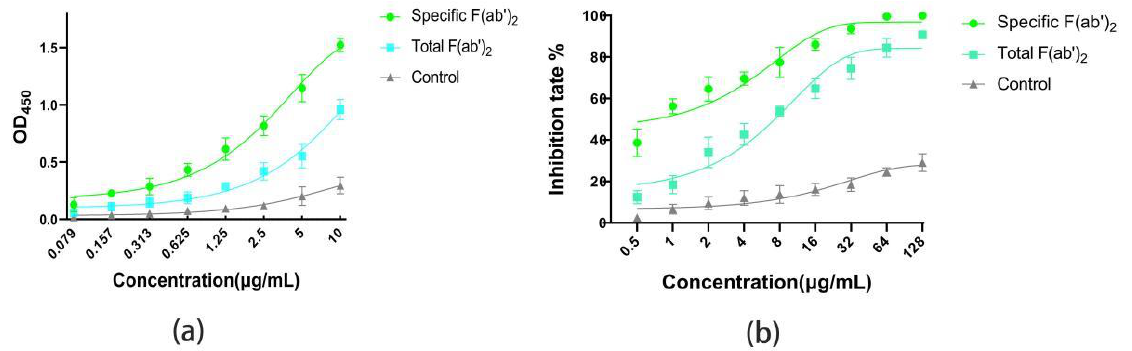
Figure 4. Comparison of the affinity and activity for specific F(ab’) 2 and total F(ab’) 2 . ( a ) The absorbance at OD 450 of the specific F(ab’) 2 and the total F(ab’) 2 by ELISA. ( b ) The inhibition rate of specific F(ab’) 2 and total F(ab’) 2 to the pseudovirus.